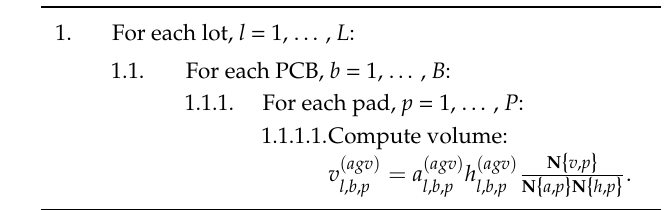
Table 9. Pseudo-code for generating the